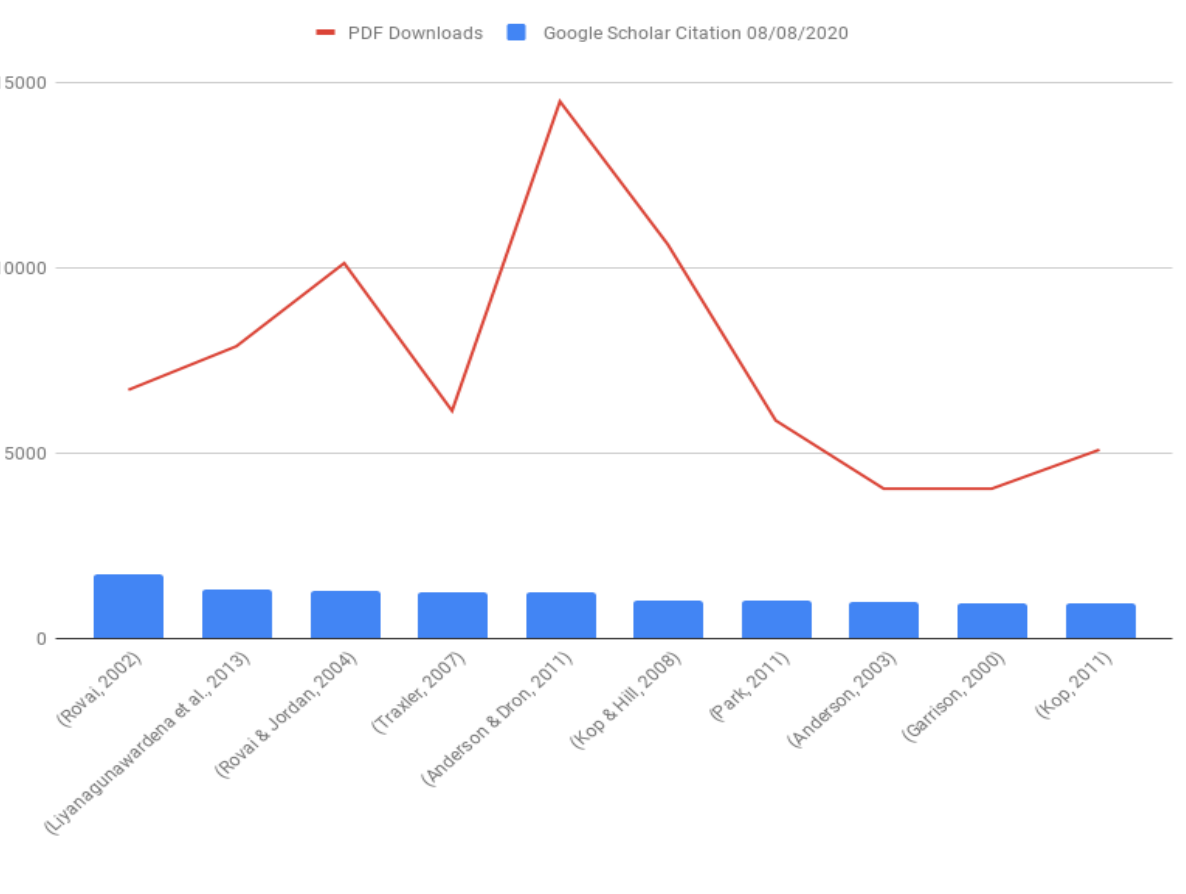
The goal of this analysis was to generate a list of the top 10 articles in terms of their enduring impact on the field of ODL. Figure 2 outlines the top 10 citation list in ascending order as identified by Google